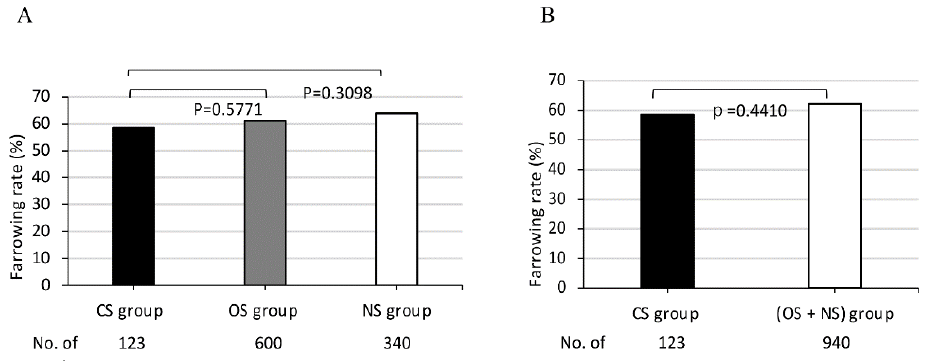
Figure 1. Comparison of farrowing rates in MMPs among ( A ) three groups CS, OS, NS, and ( B ) between two groups ( B ), CS and (OS + NS). CS, completely sharing SLA class I haplotypes between partners; OS, sharing only one SLA class I haplotype between partners; NS, non-sharing of SLA class I haplotypes between partners. X-axis shows CS, OS, and NS groups ( A ) and CS and (OS + NS) groups ( B ) and the number of matings for each group. Y-axis shows farrowing rate as indicated by the ratio (%) of the number of deliveries to the number of matings, expressed as the mean value (bar). Black and white bars represent lower and higher farrowing rate, respectively, of the mean values. Gray bars represent intermediate farrowing rate of the mean values between those of black and white bars.